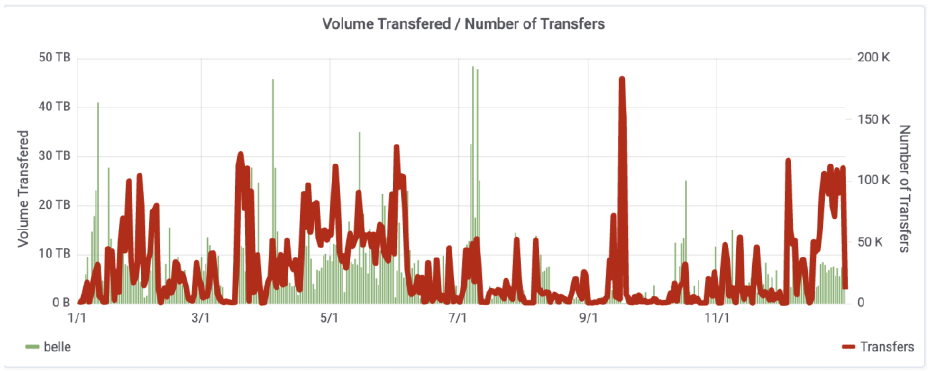
Fig. 3. Daily transfers performed by the Belle II DDMS during 2019 using the FTS